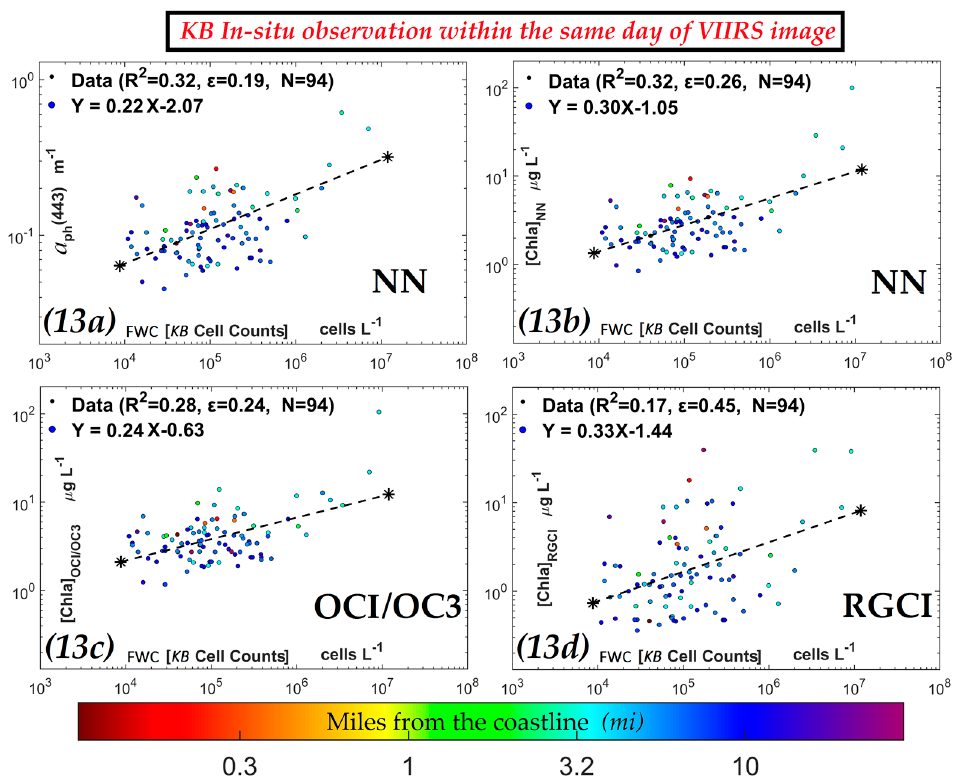
Figure 13. In situ observation within the same day of VIIRS image: ( a ) VIIRS NN retrieved a ph 443 against in situ KB cell counts; ( b ) VIIRS NN equiv. [ Chla ] against in situ cell counts; ( c ) VIIRS OCI/OC3 retrieved [ Chla ] against in situ KB cell counts; ( d ) VIIRS RGCI retrieved [ Chla ] against in situ KB cell counts. Color coding of the dots denotes distance to shore, with blue being the closest.